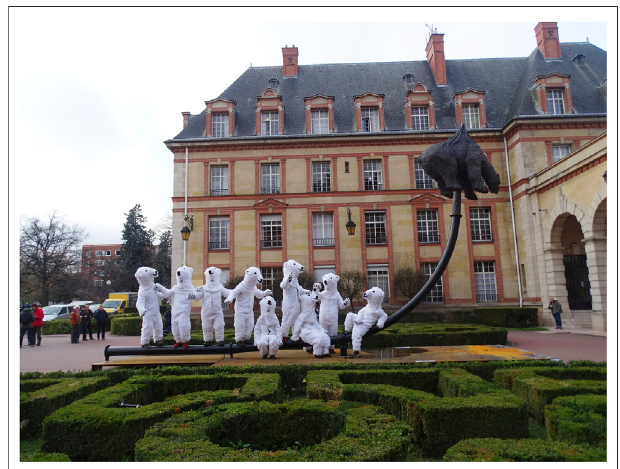
FIGURE 1 | Polar bear army in front of Unbearable (Galschiot, 2015), shared under CC BY-SA